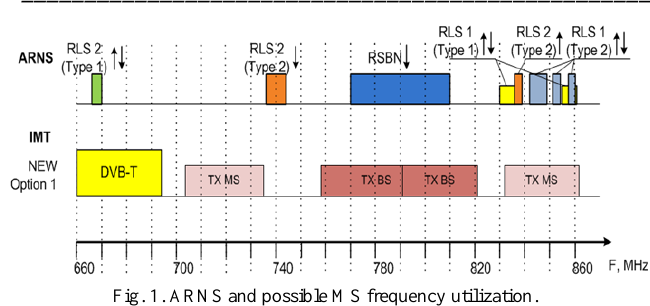
Fig. 1. ARNS and possible MS frequency utilization.